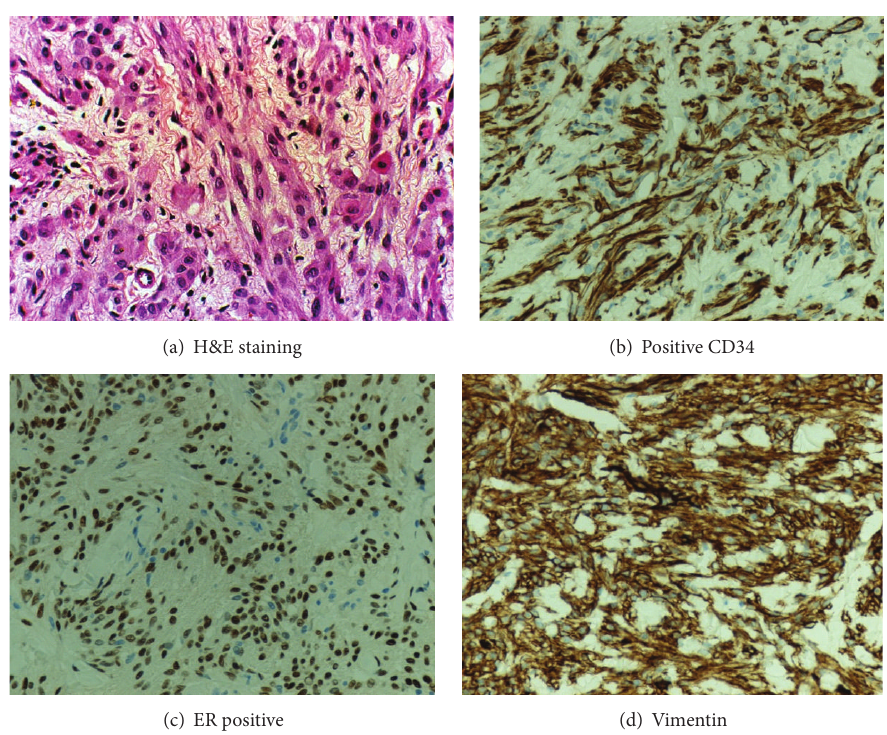
Figure 2: The histological pictures of the specimen as obtained from the histopathology